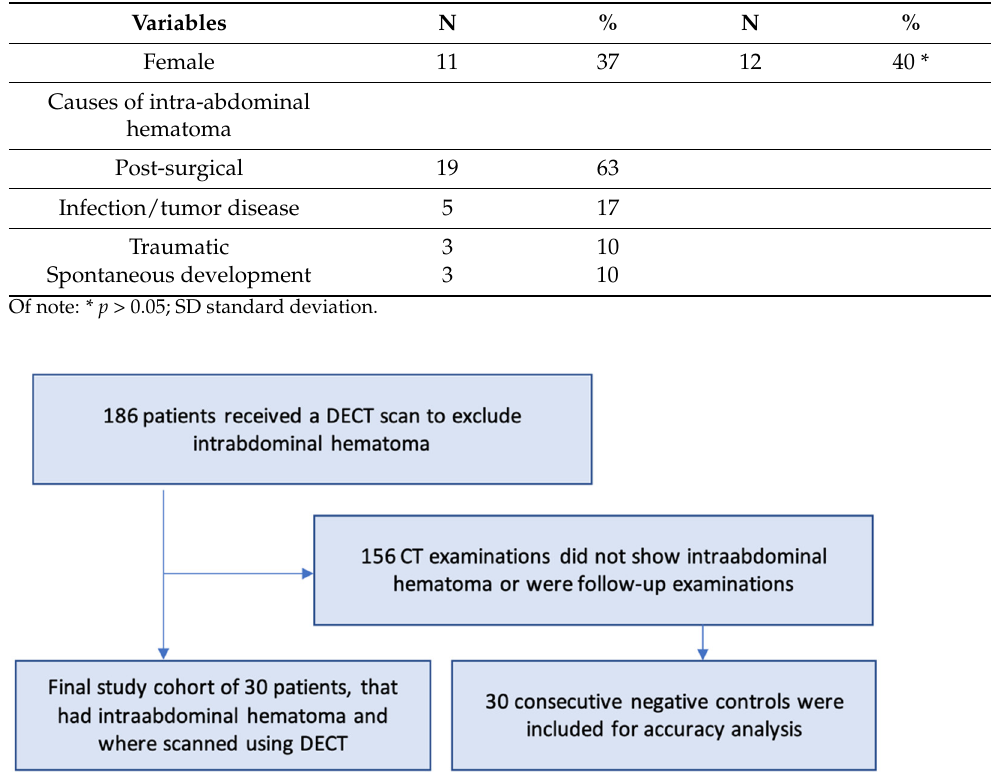
Figure 1. Flowchart of the study cohort selection. Of note, DECT: dual-energy CT.